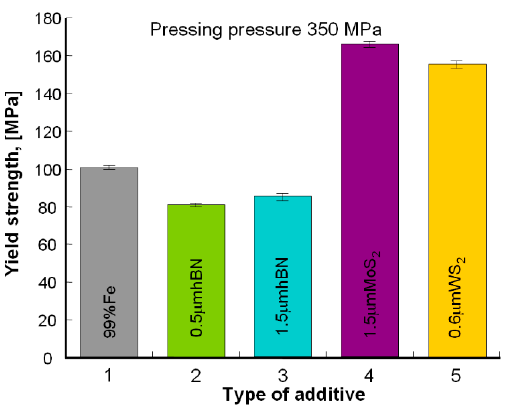
Figure 6. Results of compression measurements of sintered samples pressed under the pressure of 350 MPa.